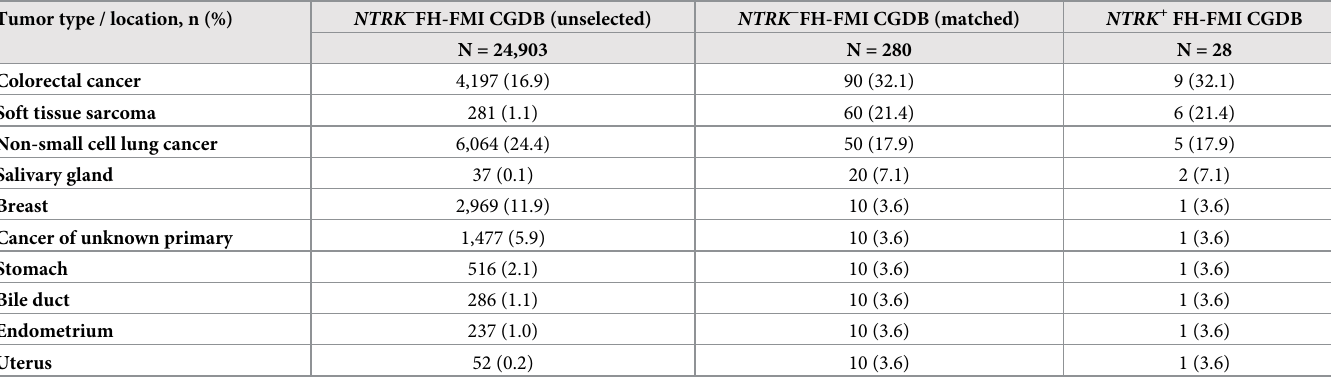
Table 1. Frequency of the tumor types found in the NTRK + cohort in the three FH-FMI CGDB cohorts of interest. Tumor type / location, n